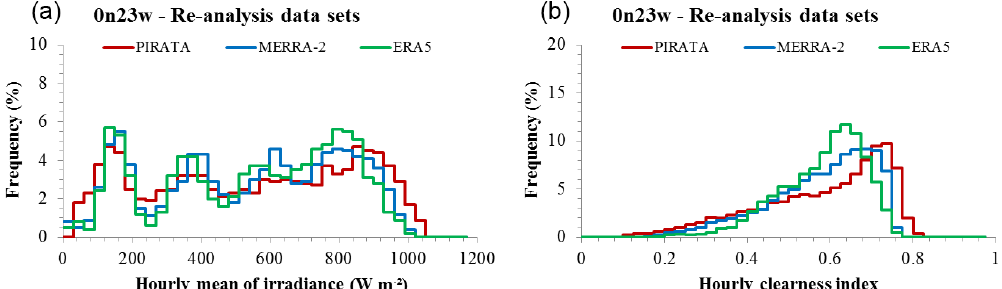
Figure C5. Frequency distributions of PIRATA measurements (red) and data sets (MERRA-2: blue, ERA5: green) at 0 ◦ N, 23 ◦ W for E (a) and KT (b) . If the coloured line is above (below) the red one for a given sub-range of values, it means that the data set produces these values too frequently (too rarely) with respect to the PIRATA